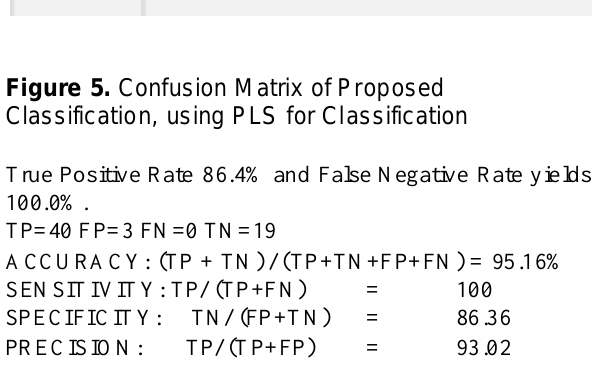
Table II : Performance Evaluation of Proposed PCA and PLS